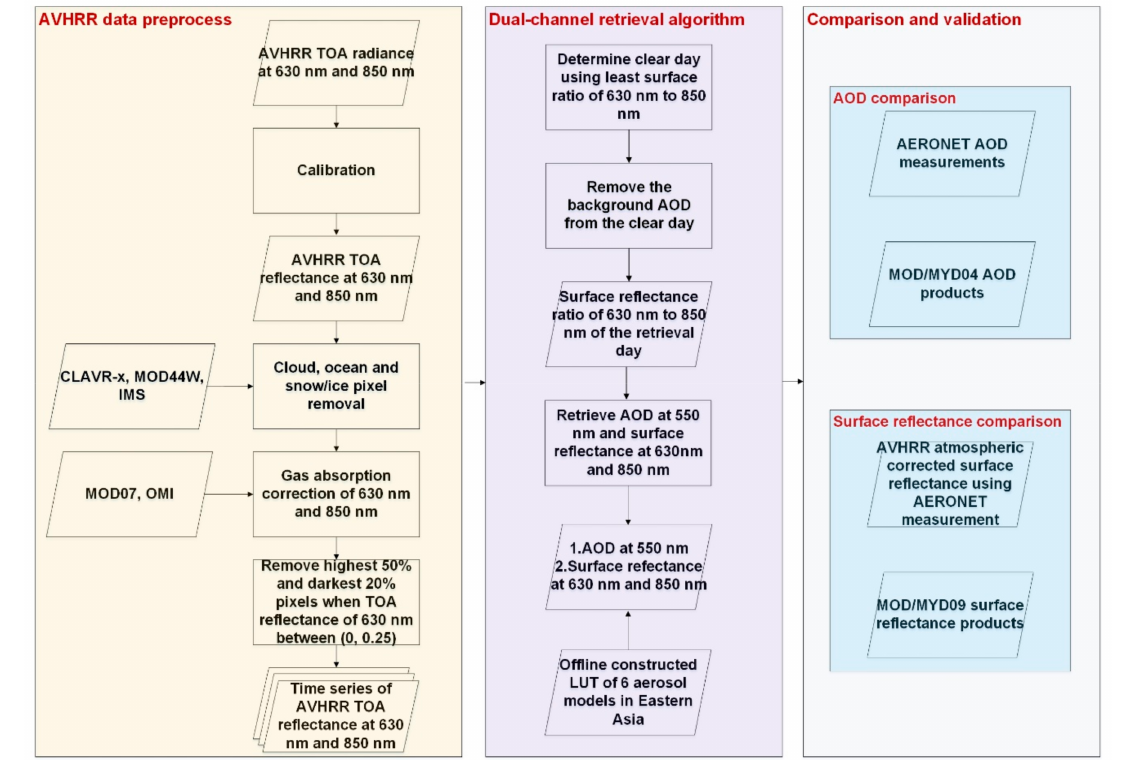
Figure 3. Flowchart of the dual-channel retrieval